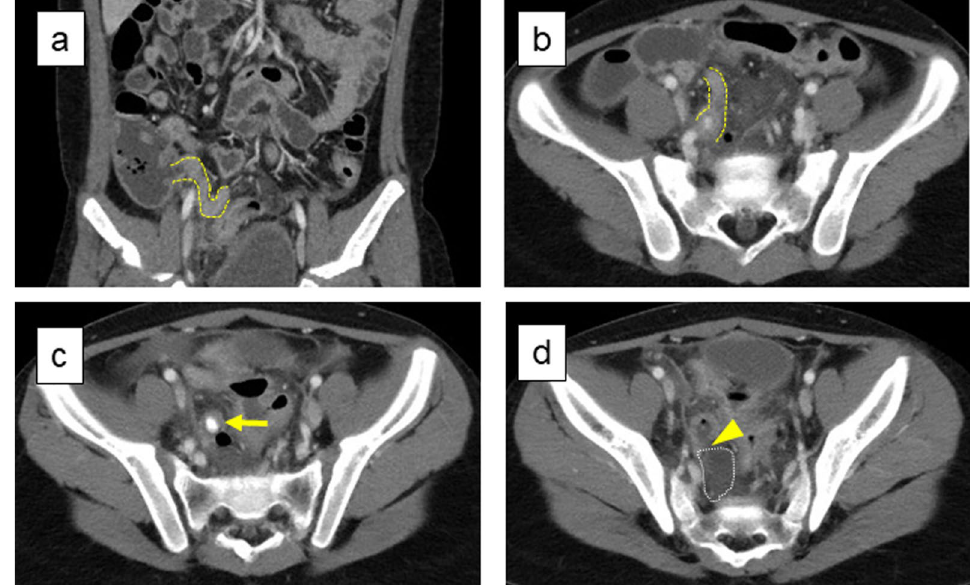
Fig. 1 Enhanced computed tomography on admission. CT showed the swollen appendix with an intact appendicular base ( a ) and body ( b ), with a fecalith in the lumen ( c ), and perforation on the apex side ( d ), accompanied by fluid collection in the peri-appendiceal region ( d ). The yellow dotted line shows the appendicular body. The yellow arrow indicates a fecalith in the lumen. The yellow arrowhead shows the point of perforation. The white dotted line shows fluid collection in the peri-appendiceal